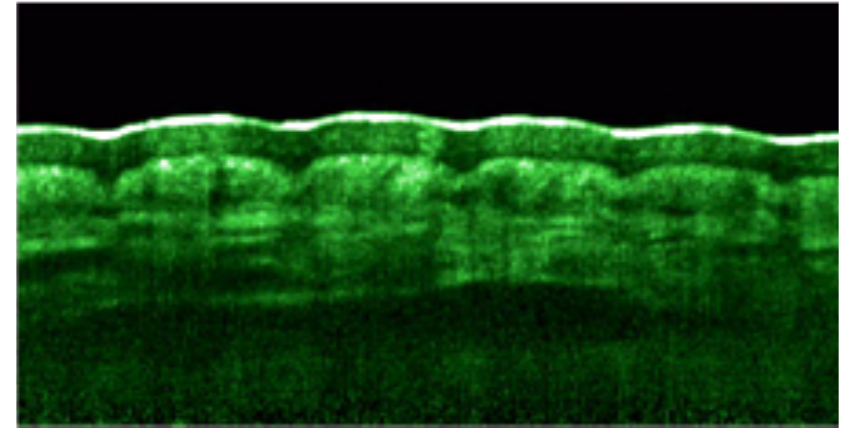
Figure 4. Speckle reduced OCT image obtained by combining 8 individual scans to suppress speckle noise. The SC is marked by the white-coloured top layer